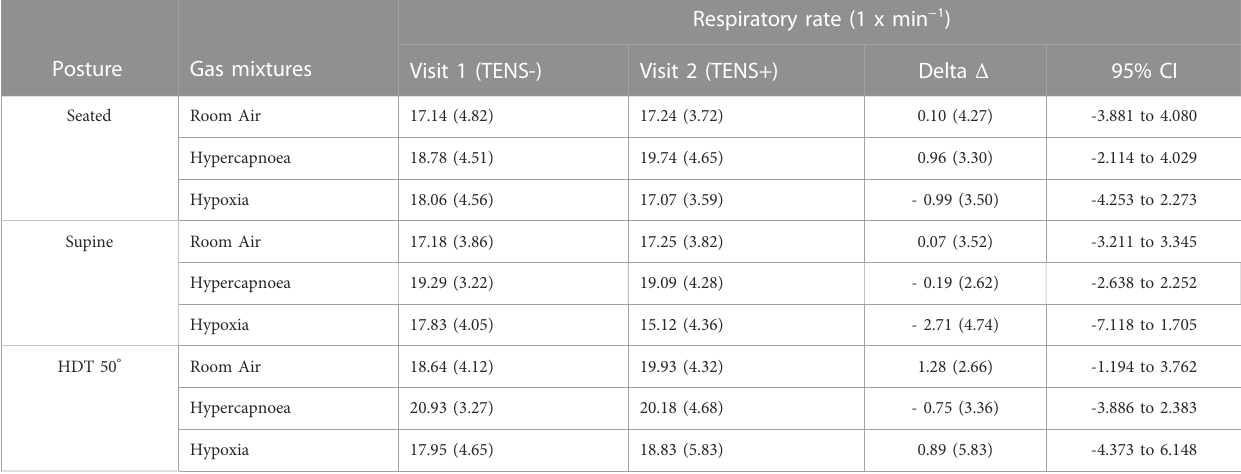
TABLE6Respiratoryratewithandwithoutelectrical stimulationinseated,supineandHDTpostures.Dataarepresentedasmean(SD),HDT:headdowntilt.TENS-, electrical current off. TENS + electrical current turned on. CI, 95% con fi dence interval.